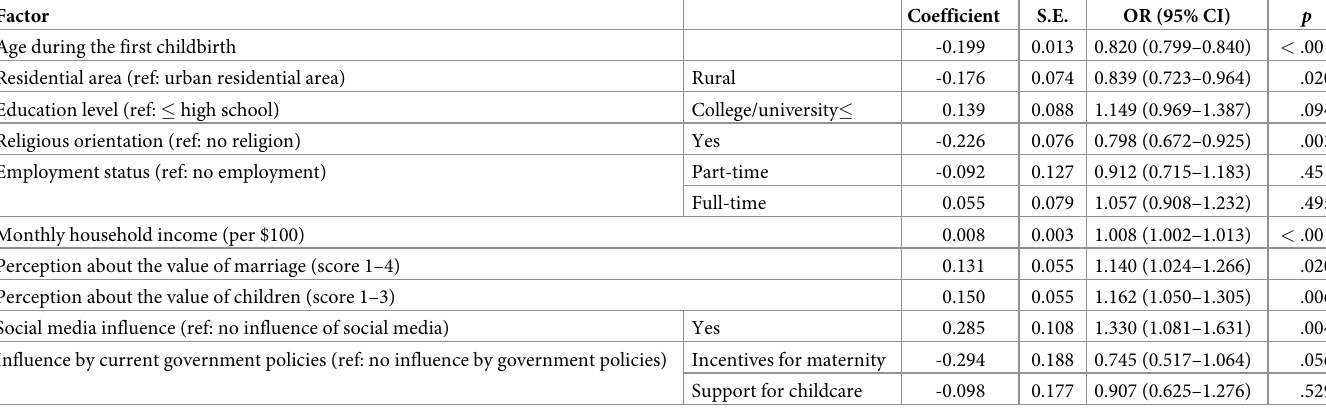
Table 3. Factors influencing women’s subsequent childbirths (ordinal logistic regression model; N = 2925).